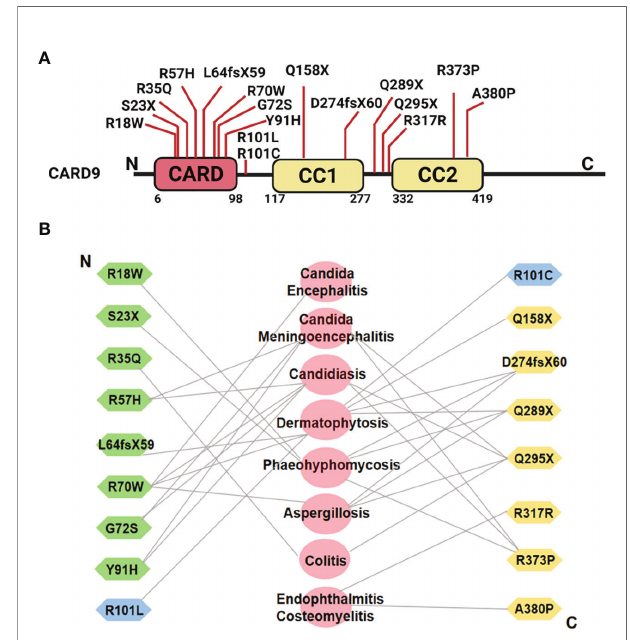
FIGURE 4 | (A) Schematicillustration of human CARD9 protein structure and reported disease-associated CARD9mutations. (B) Relation between CARD9 mutationsand diseases from N-terminus to C-terminus. Symbolsin green represent the CARD9mutationsin CARDdomain. Symbolsinyellow indicate the CARD9 mutationsincoiled-coildomain. Symbolsin blue indicate the CARD9 mutationsin the region between CARDdomainand coiled-coil domain. The diseases associated with individualmutationsare shown inthe middlein